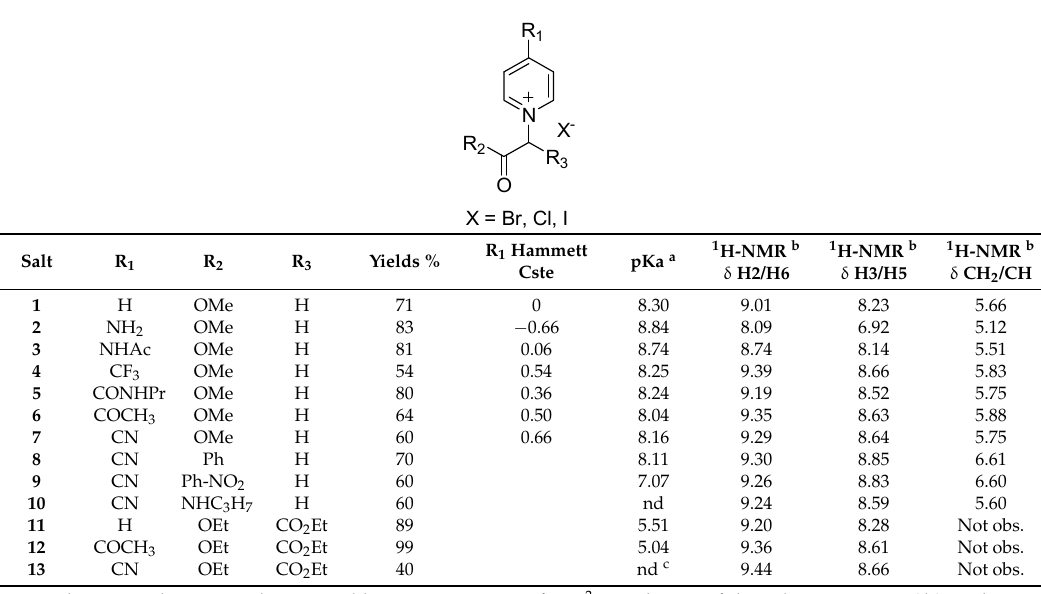
Molecules 2016 , 21 , 332 Table 1. Structures, yields, pKa values, and proton NMR data of the pyridinium salts. Table 1. Structures, yields, pKa values, and proton NMR data of the pyridinium